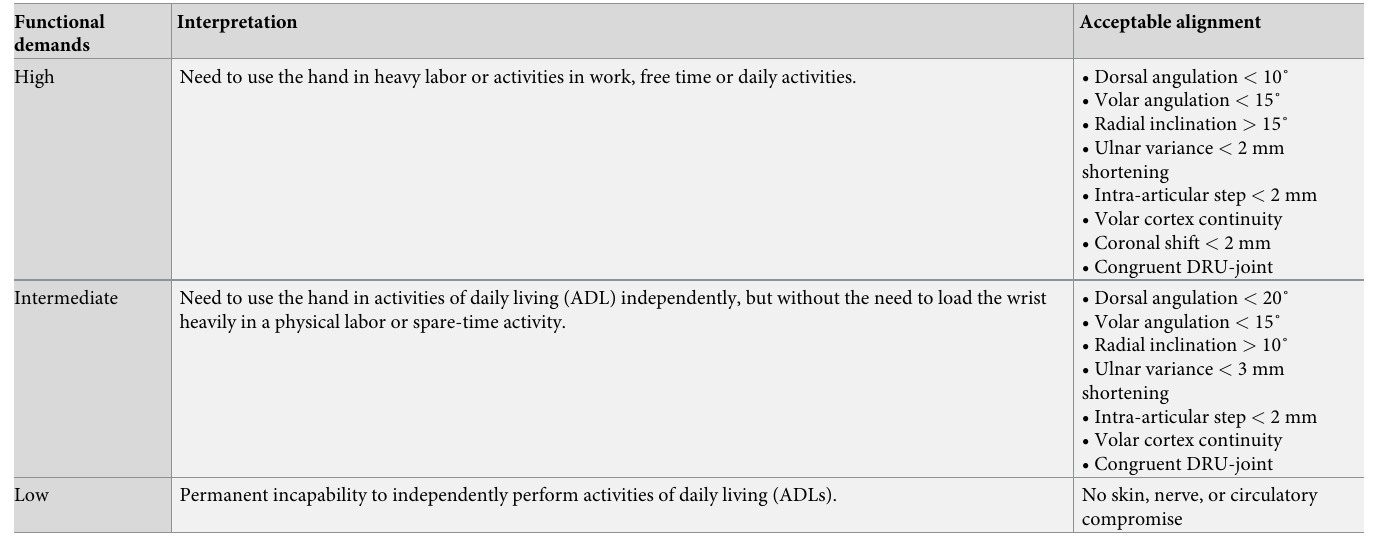
Table 1. Functional demands and treatment thresholds as presented by the Swedish national guidelines for DRFs [30]. Functional